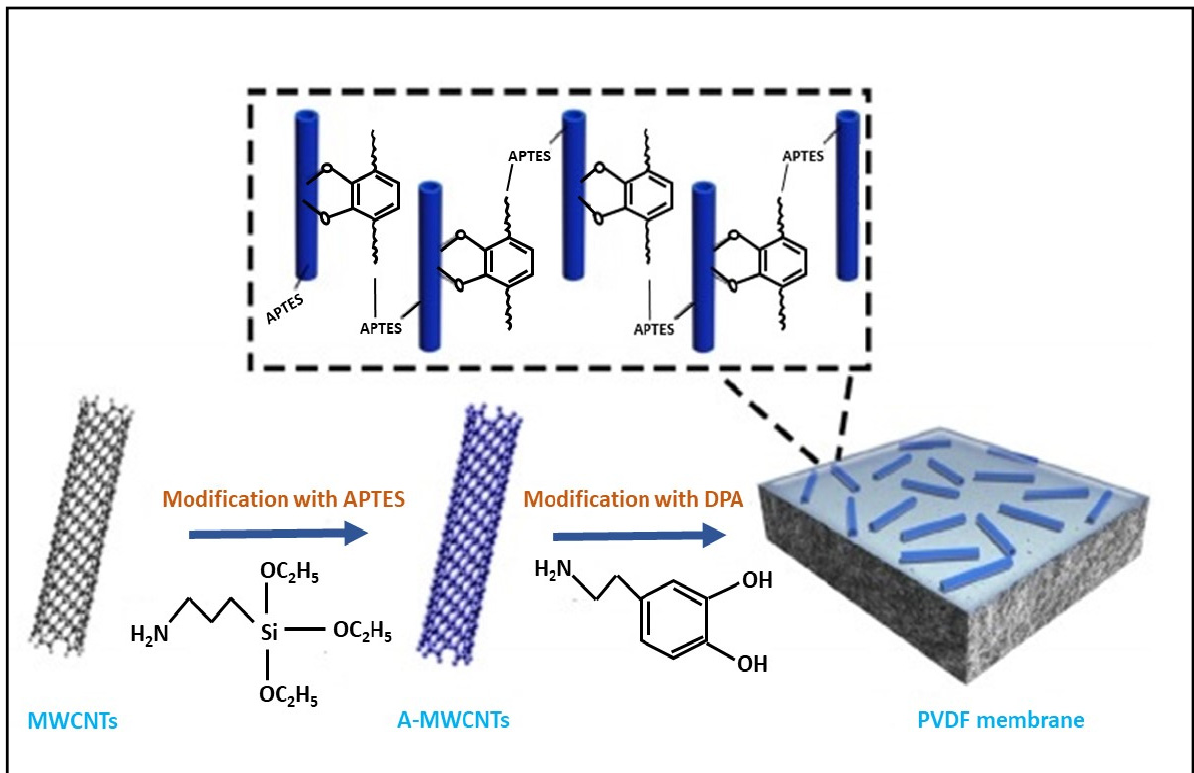
Figure 10. Schematic diagram of fabrication dopamine/3-aminopropyltriethoxysilane-multiwall carbon nanotubes (DA/APTES-MWCNTs) decorated superhydrophilic polyvinylidene fluoride PVDF membrane. Reprinted with permission from ref. [46]. © 2019 Springer Science+Business Media, LLC, part of Springer Nature.